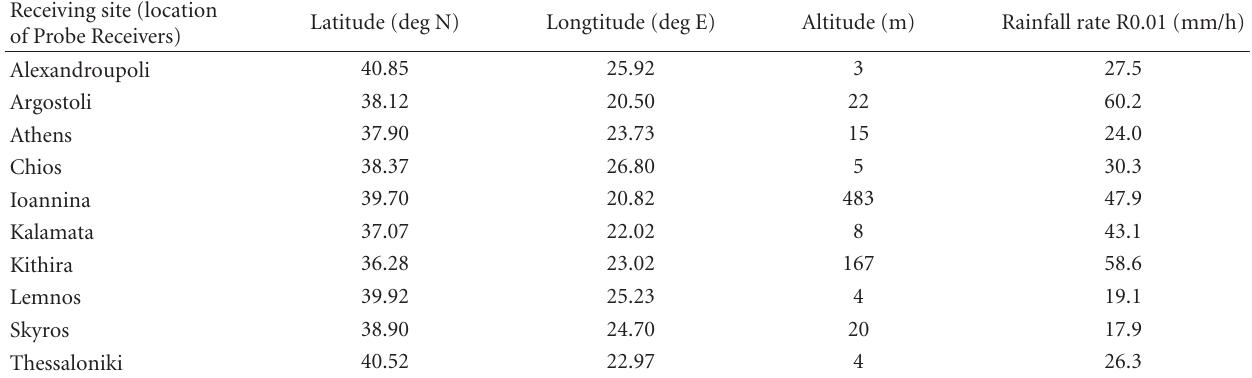
Table 2: Scenario 1; receiving sites across Greece.